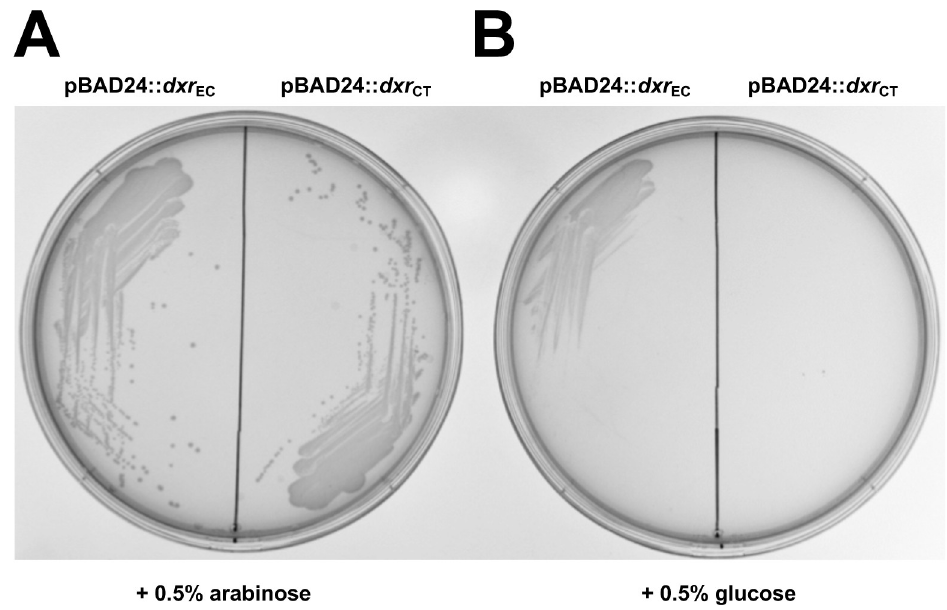
Fig 3. Expression of Dxr CT in trans supports growth of an E . coli dxr conditionally lethal mutant. Five μ L of an overnight culture of E . coli MG1655 Δ dxr :: kan pBAD24:: dxr EC (ATM1471) or E . coli MG1655 Δ dxr :: kan pBAD24:: dxr CT (ATM1470) grown in the presence of 0.2% arabinose were streaked for isolation on an LB agar plate containing 0.5% arabinose (A) or 0.5% glucose (B). Images are representative of three independent experiments performed in